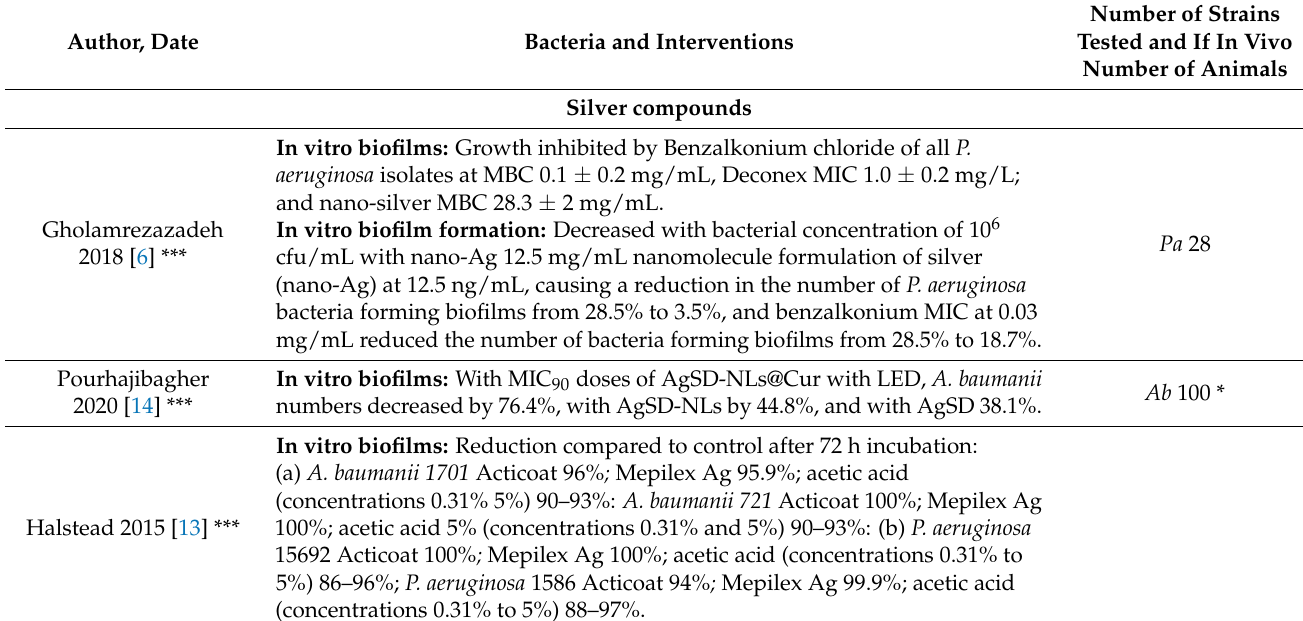
Table 1. Reductions in vivo and in vitro biofilms after